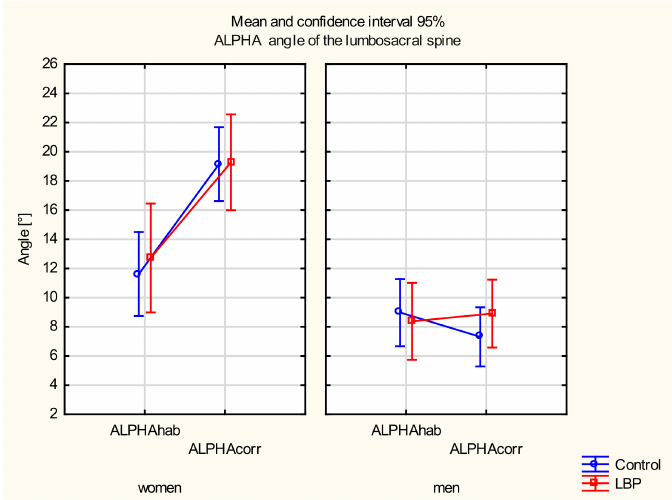
Figure 3. Mean and 95% CI of the ALPHA angle of the lumbosacral spine in women and men in habitual (hab) and corrected (corr) positions, in the control and LBP